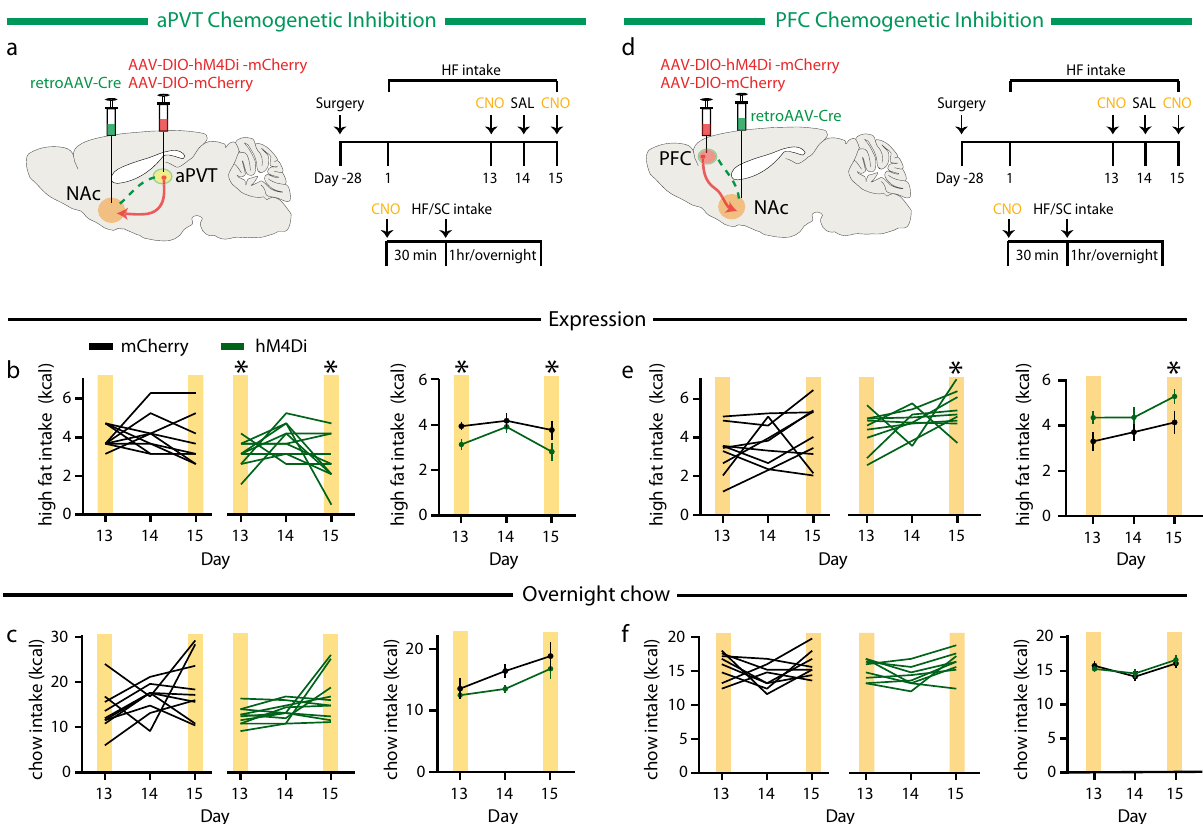
Fig. 3 Inhibition of distinct NAc projecting neurons selectively regulates high fat intake. a Schematic of viral injection for NAc projecting aPVT neuron inhibition (left); experimental timeline (right). b Quanti fi cation of high fat intake during expression period ( F 1,18 = 4.94, P = 0.03, n = 10 mice/group) in mCherry control (black) and hM4Di expressing (green) mice. Yellow bars signify CNO administration. c Quanti fi cation of overnight standard chow intake during expression period ( F 1,18 = 3.5, P > 0.05, n = 10 mice/group) in mCherry control (black) and hM4Di expressing (green) mice. d Schematic of viral injection for NAc projecting PFC neuron inhibition (left); experimental timeline (right). e Quanti fi cation of high fat intake during expression period ( F 1,17 = 5.27, P = 0.03, n = 9, 10 mice/group) in mCherry control (black) and hM4Di expressing (green) mice. f Quanti fi cation of overnight standard chow intake during expression period ( F 1,17 = 0.19, P > 0.05, n = 9, 10 mice/group) in mCherry control (black) and hM4Di expressing (green) mice. Data are ±s.e.m. * P < 0.05, two-way ANOVA with Sidak ’ s or Tukey ’ s multiple comparison post hoc test. Source data are provided as a Source Data fi